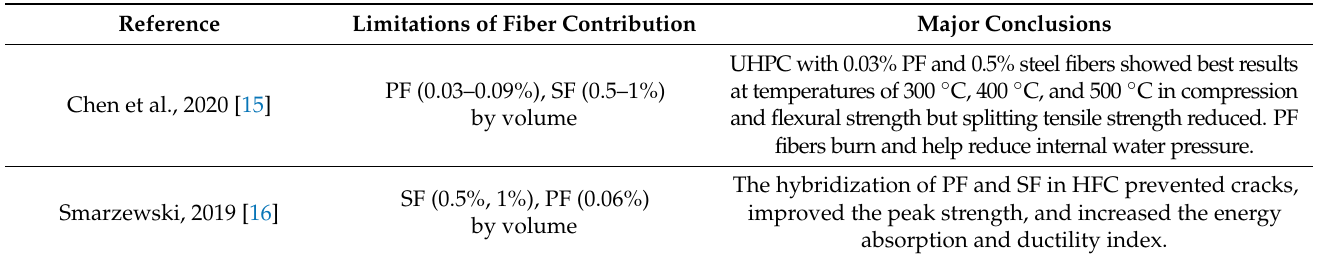
Table 1. Some of the available studies on hybrid fiber-reinforced